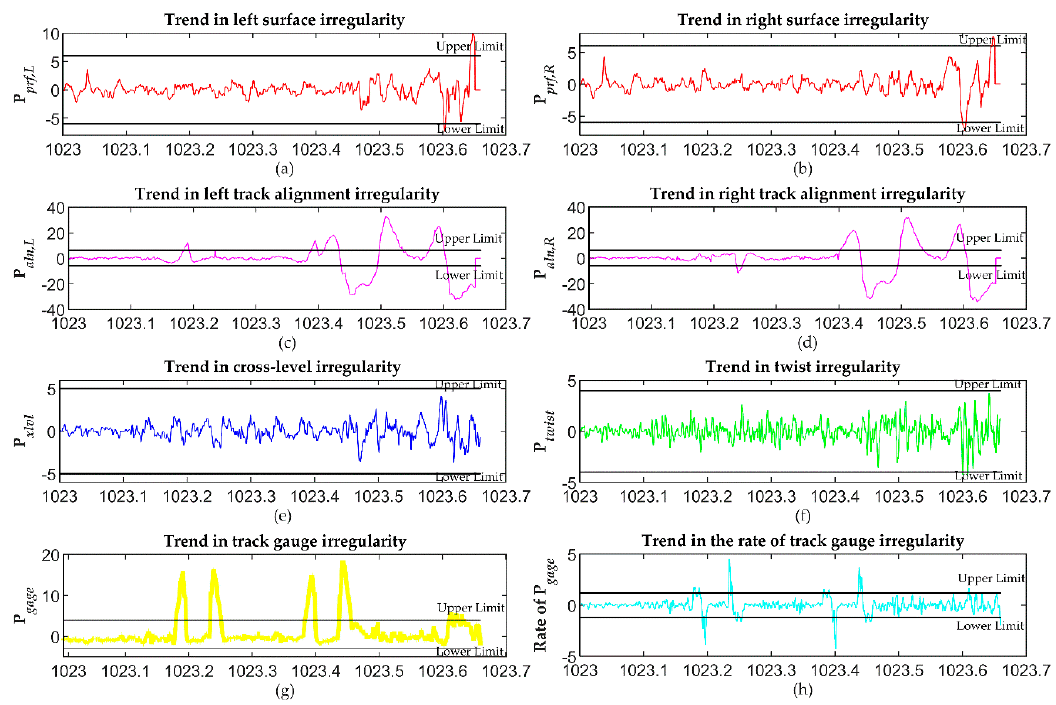
Figure 3. Trend in the geometric parameters from K1023 to K1024 (unit: km): ( a ) Left surface irregularity, ( b ) right surface irregularity, ( c ) left track alignment irregularity, ( d ) right track alignment irregularity, ( e ) cross-level irregularity, ( f ) twist irregularity, ( g ) track gauge irregularity, and ( h ) the rate of track gauge irregularity.